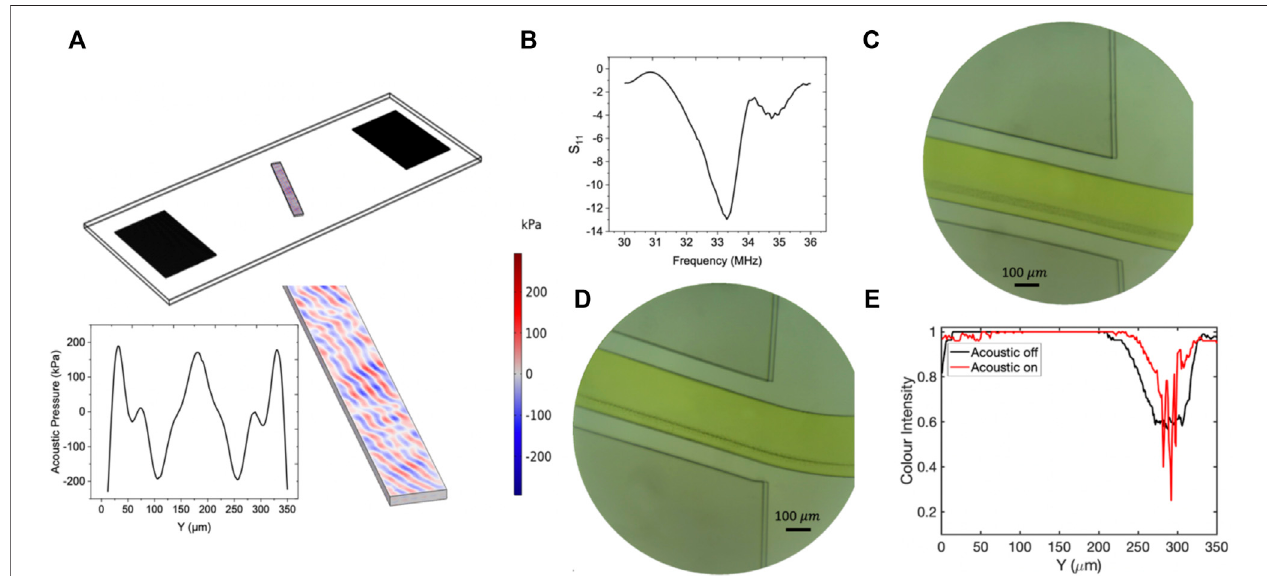
FIGURE 10 | The results of the numerical and experimental studies corresponding to experiment number 36 with tilt angle 20 ° . (A) Contours of the acoustic pressure fi elddistributioninsidethe fl uidicdomain. (B) Thefrequencyresponseoftheresonator. (C) The fl owof0 . 5 μ m particlesbeforeapplyingtheacousticforceatthe channel ’ send. (D) Con fi nementof0 . 5 μ m particlesafterapplyingtheacoustic fi eldatthechannel ’ send. (E) Graphofcomparisoncolorintensityacrossthemicrochannel before and after applying the SSAW fi eld. (The lower color intensity corresponds to darker color).